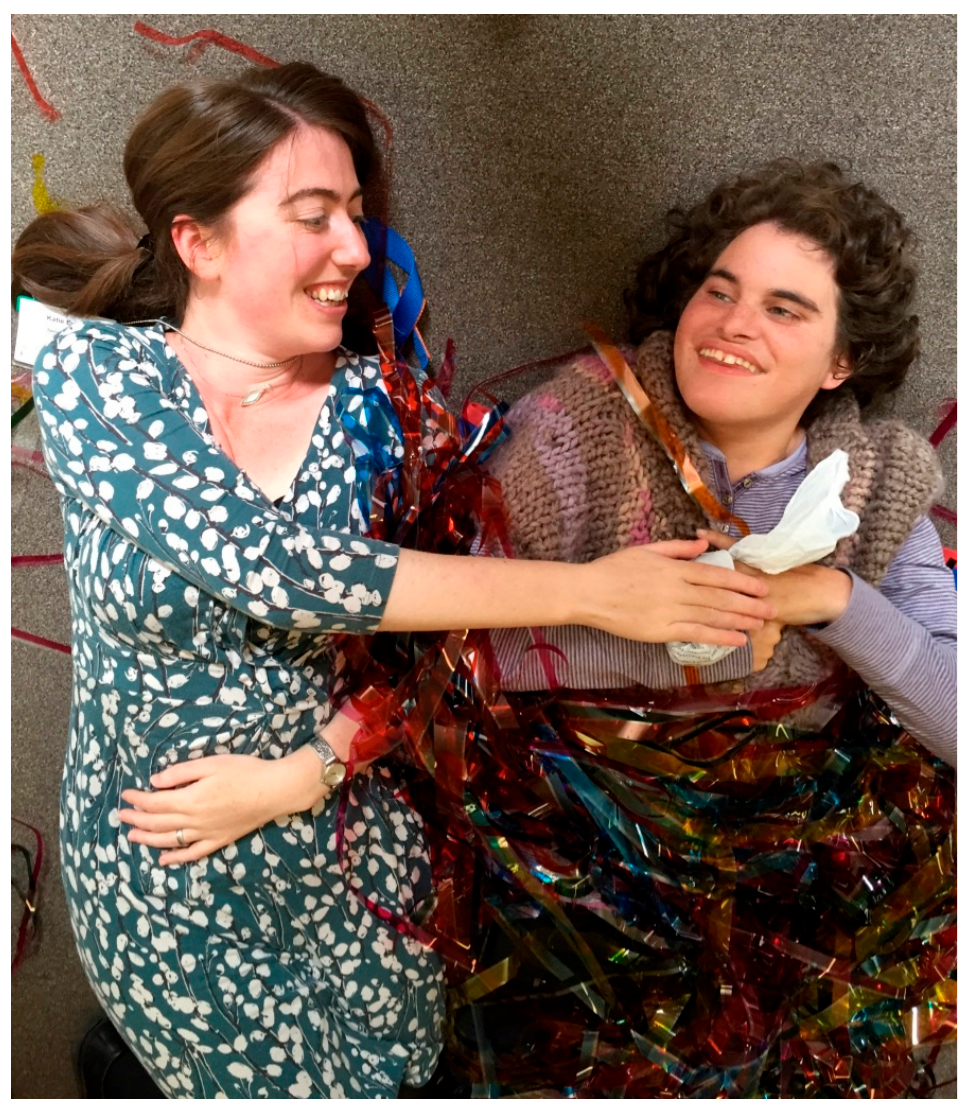
Figure 3. Johanna and Kate ‘being with’ each other.